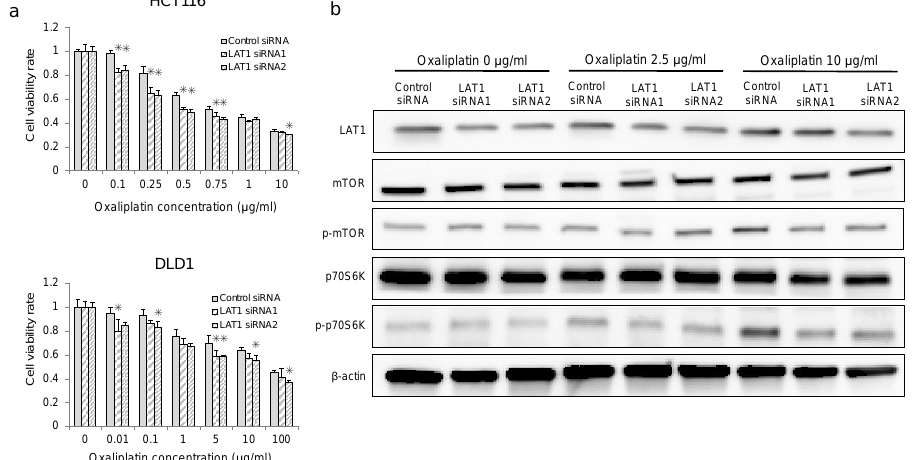
Figure 4. Analysis of oxaliplatin chemosensitivity and mTOR-related proteins in LAT1-suppressed CRC cells. ( a ) Oxaliplatin sensitivity was evaluated in HCT116 and DLD1 cells treated with LAT1 siRNAs using a Cell Counting Kit-8 kit. * p < 0.05, ** p < 0.01. ( b ) LAT1, mTOR, p-mTOR, p70S6K, and p-p70S6K expression in LAT1 suppressed CRC cells after treatment with oxaliplatin for 48 h, visualized using Western blot. β -Actin was used as the loading